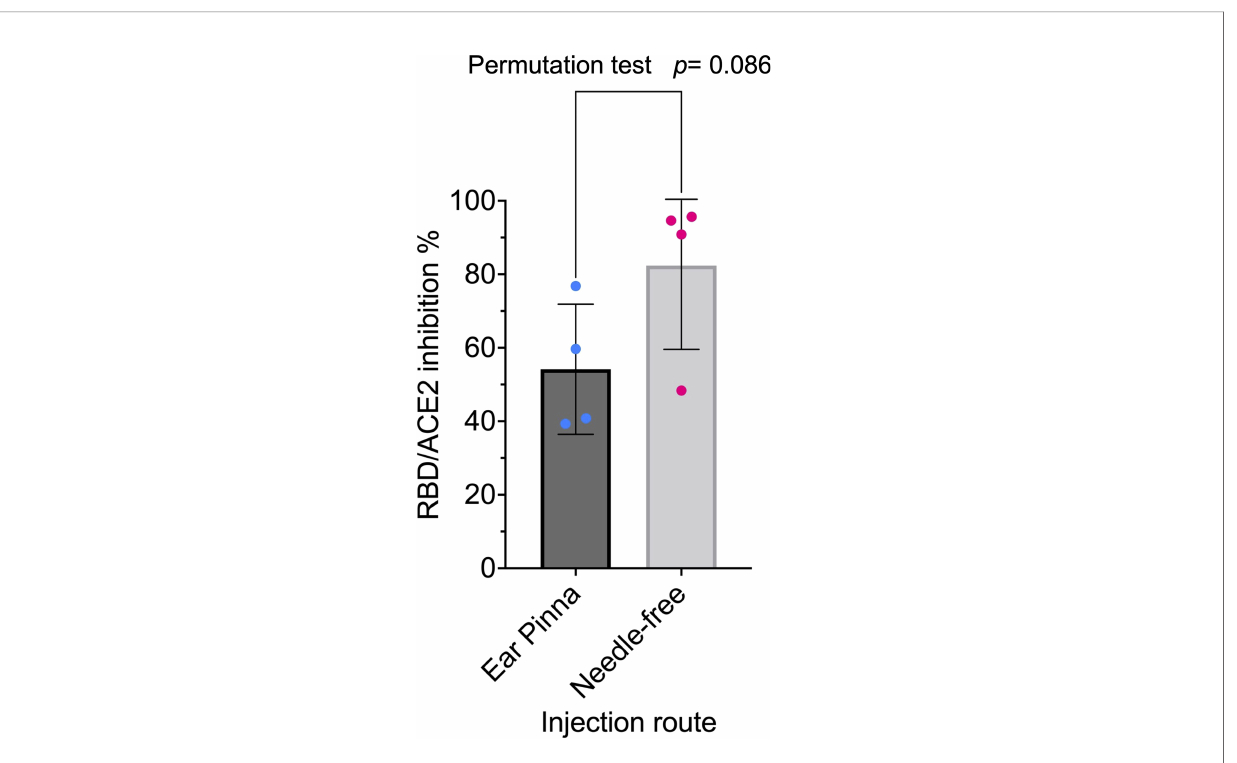
FIGURE 2 | Needle-free injection route is superior for RBD-NP vaccine: Eight-week-old CB6F1/J female mice were primed at week 0 and boosted at week 2 with the same dose (42µg/50µl) of the mRNA RBD-NP vaccine with the wild type RBD. Group 1 (n= 4) by i.d. injection at the ear pinna and Group 2 (n= 4) by i.m. needle-free injection at the caudal thigh with the modi fi ed Tropis ® injector. Serum samples collected in week 4 were analyzed with the SARS-CoV-2 neutralization antibody assay. Group 1: mean= 54.2%, SEM= 8.8, Group 2: mean= 82.4%, SEM= 11.4. The difference in means between the two samples of small size was analyzed with a standard two-sided permutation test ( p -value=